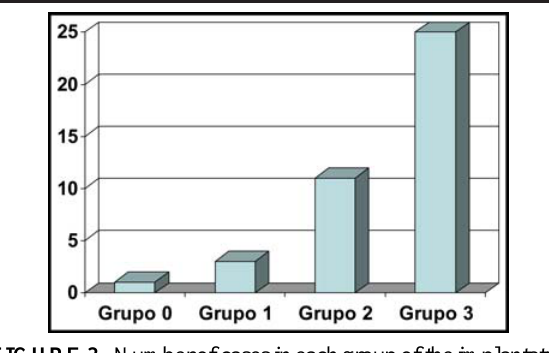
FIGURE 3 - Number of cases in each group of the implantation classification system for growth degree according to Quereda et al 5 , showing a greater number in the most developed groups (II and III).